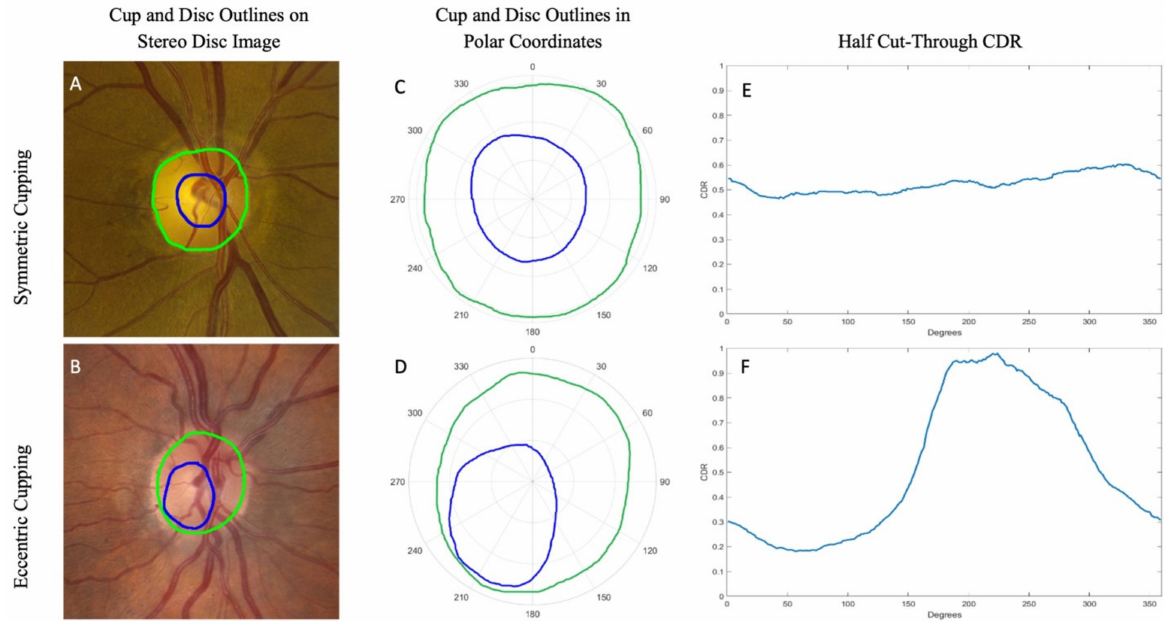
Figure 2. Examples of outlined stereo disc photos converted into polar coordinates for eyes (OD) with symmetric and eccentric cups, both from Bin 6 (0.5 ≤ CDR < 0.6). The stereo disc photos of patients with symmetric cupping ( A ) and eccentric cupping ( B ) are shown, both with a CDR in Bin 6 and outlined for cup contour (blue) and disc (green). The same contours were converted into polar coordinates ( C , D ), and the half cut-through CDRs at each degree location for these images were plotted ( E , F